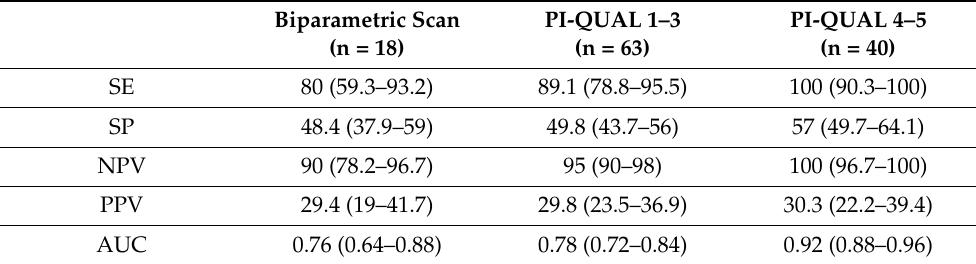
Table 3. Diagnostic performance of MRI for prediction of EPE final Likert score ≥ 3 for biparametric MRI scans and mpMRI PI-QUAL scores of 1–3 and